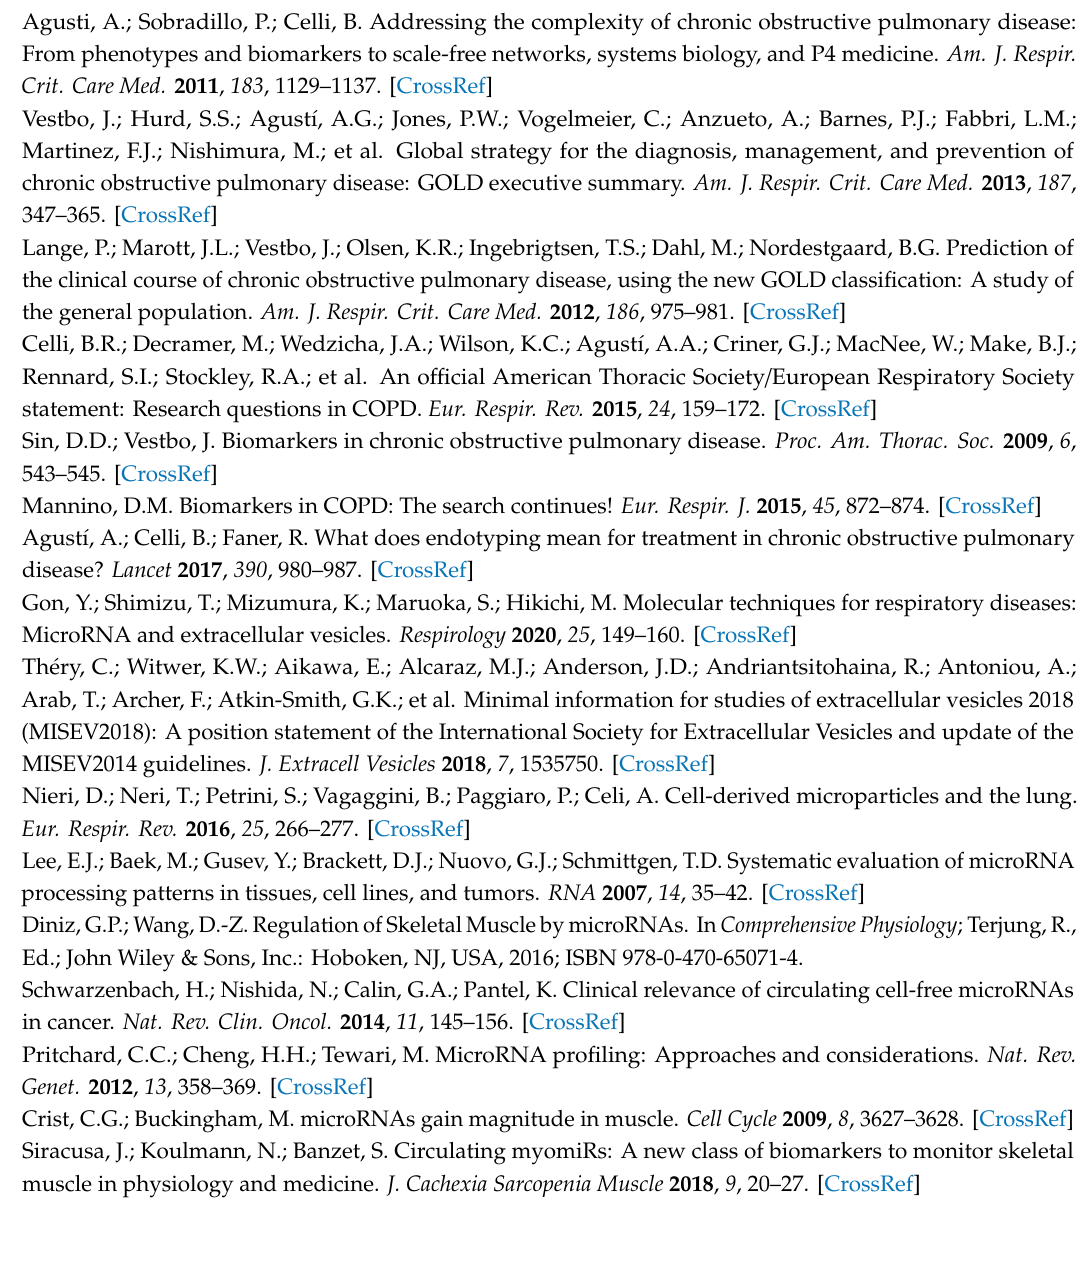
s1. Figure S1: ROC curve analysis of the three striated muscle-specific microRNAs (miR-206, miR-133a-5p, and miR-133a-3p.2), which were significantly up—regulated in plasma-derived extracellular vesicles from group B of chronic obstructive pulmonary disease (COPD) patients in comparison with group A, C, and D. ROC, receiver operating